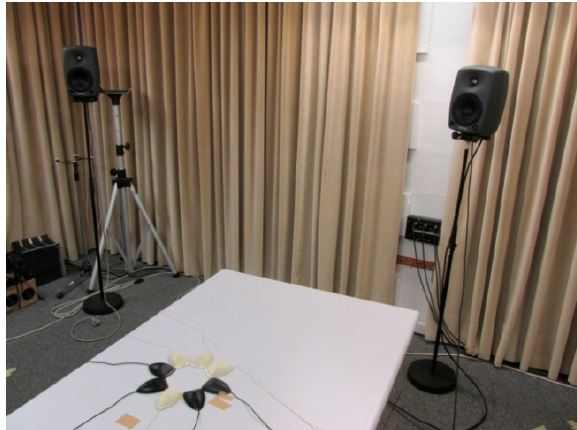
Figure 8. The real recording room in the speech processing laboratory, FBK, Trento, Italy.